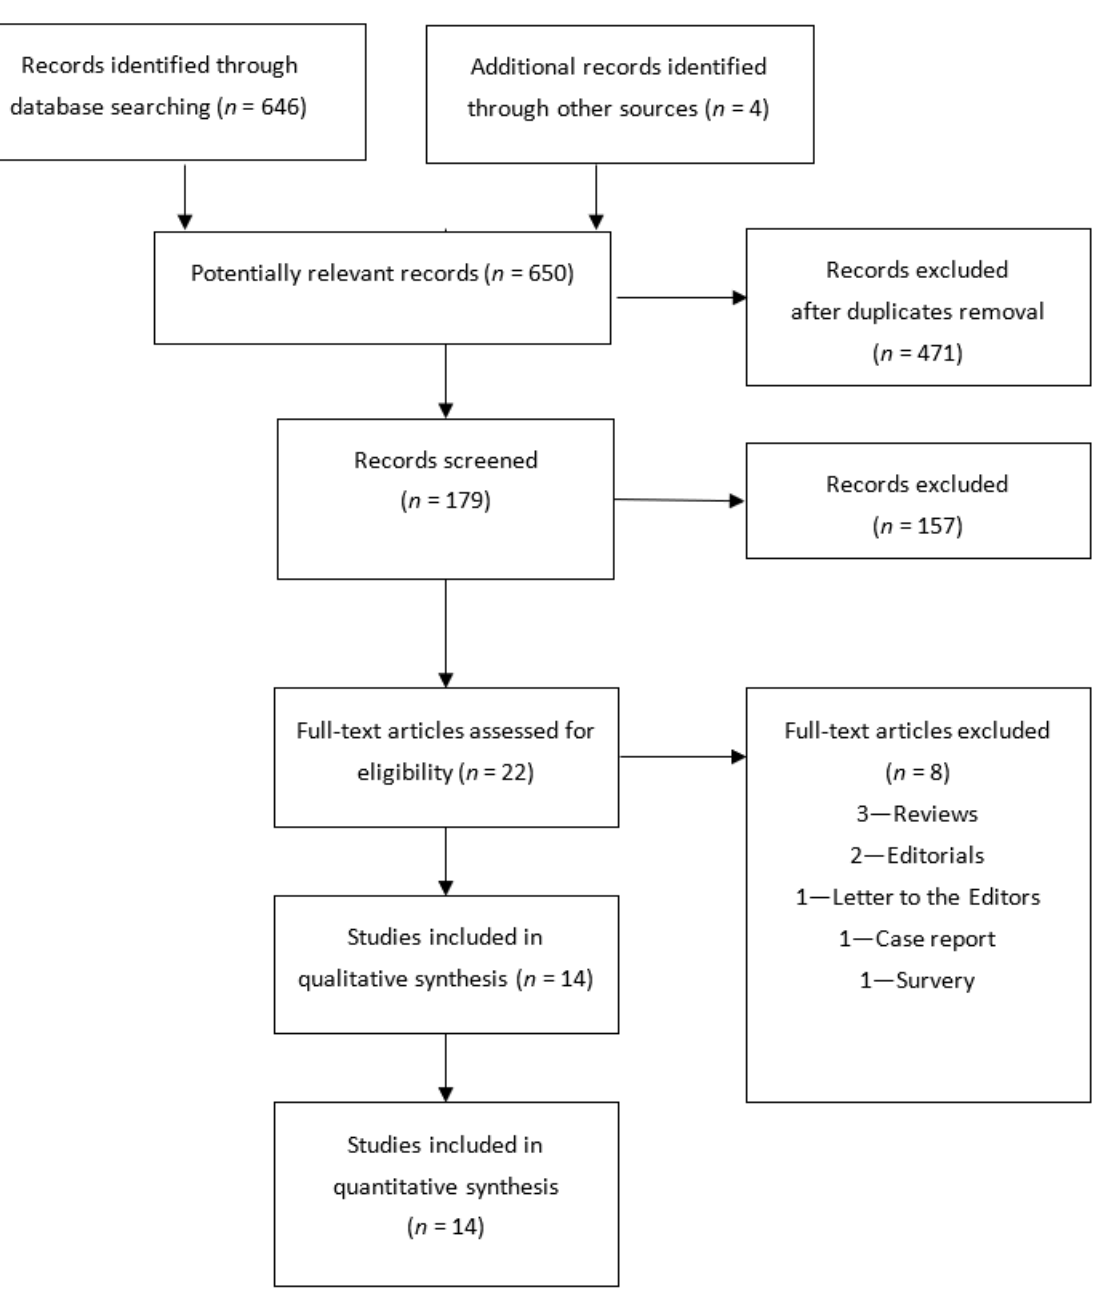
Figure 1. PRISMA flow diagram of study search.